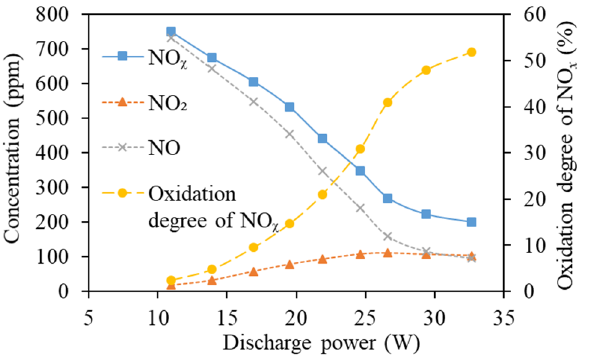
Figure 10. Effects of discharge power on NO, NO 2 , and NO x concentrations and the oxidation degree of NO x at the outlet of the DBD reactor.